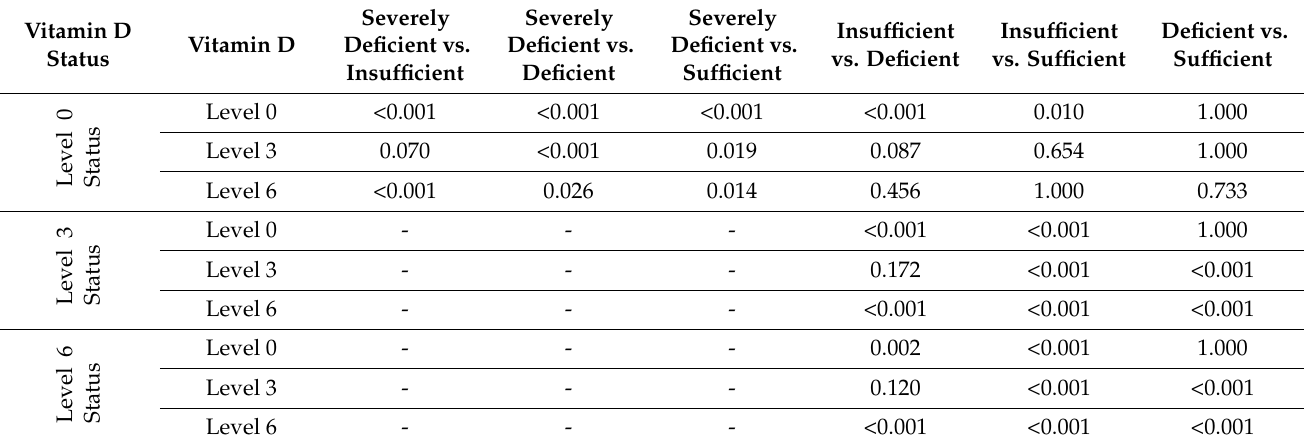
Table 4. Summary of two samples